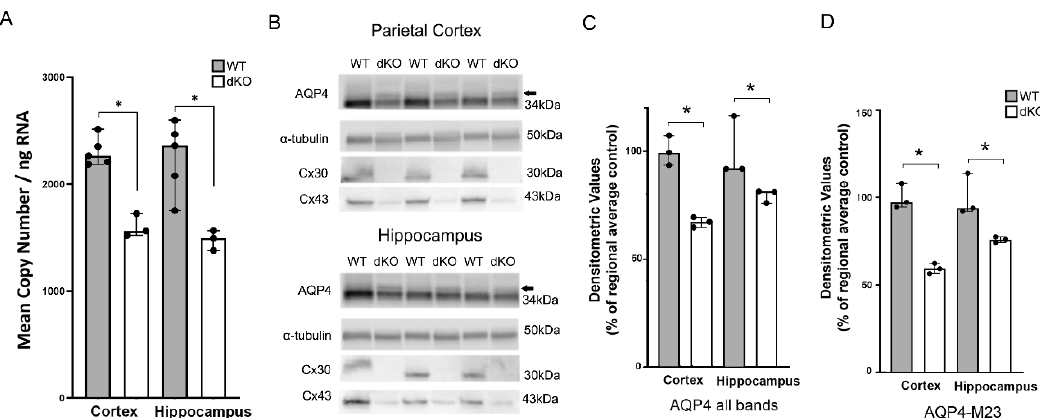
Figure 3. RT-qPCR and Western blot analysis of AQP4 in WT and Cx43 / 30 dKO mice. ( A ) RT-qPCR analysis of parietal cortex and hippocampus in WT and Cx43 / 30 dKO mice. Graph illustrates quantification of Aqp4 mRNA. Significant decrease in the mRNA level of Aqp4 was found in the samples of Gja1 and Gjb6 dKO compared to WT mice in each region. A combination of Gapdh and Hprt1 was used for normalization of copy numbers. * Significant di ff erence according to independent samples t- test; n = 3 for each genotype; error bars SEM; p < 0.05. ( B ) Representative immunoblots of total protein lysates from hippocampus and parietal cortex for AQP4 in WT and Cx43 / 30 dKO animals. Two major bands detected in homogenates from both regions correspond to M1 (arrow) and M23 isoforms of AQP4. α -tubulin was used as the loading control. dKO animals are negative for Cx30 and Cx43 protein. ( C ) Quantitation of total AQP4 in cortex and hippocampus of WT and Cx43 / 30 dKO mice. Significant decrease in total AQP4 protein was found in both regions of Cx43 / 30 dKO animals compared to WT mice. ( D ) Quantitation of the AQP4 M23 isoform in cortex and hippocampus of WT and Cx43 / 30 dKO mice. Significant decrease in the AQP4 M23 was found in both regions of Cx43 / 30 dKO animals compared to WT. Values are presented as average of the respective wild type regional control. Individual values are presented as black dots. * Significant di ff erence according to non-parametric Kruskal–Wallis test; n = 3 for each genotype; error bars indicate medians with 95% CI, p < 0.05.